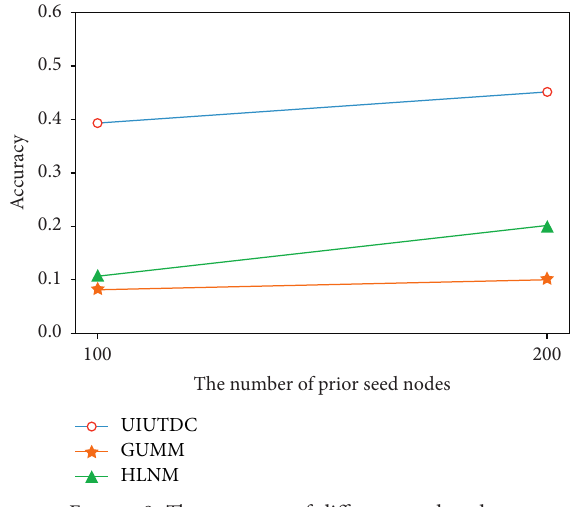
Figure 8: The accuracy of different seed